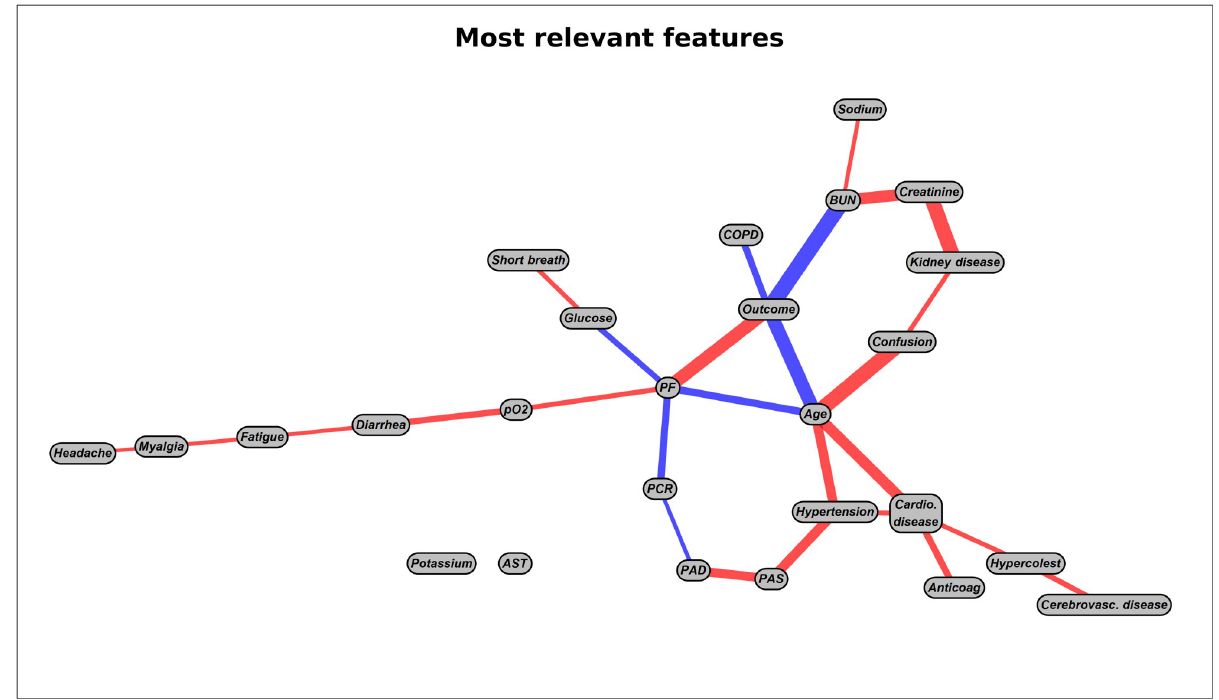
Fig 3. BSL analysis on the most relevant features. Graph generated with the most relevant features found from the graphs shown in Fig 2, taking the information provided by clinicians into account.